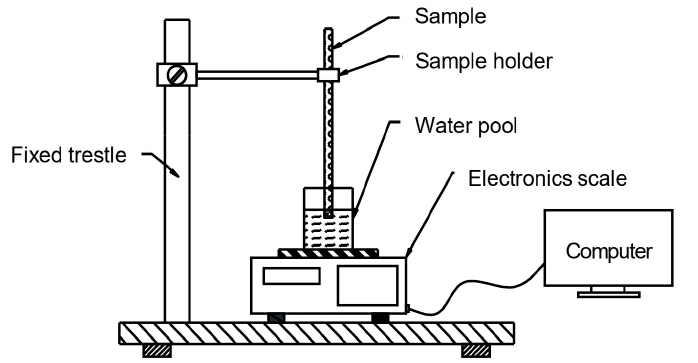
Figure 4. The apparatuses for measuring the capillary characteristics of the sintered porous cop- per.